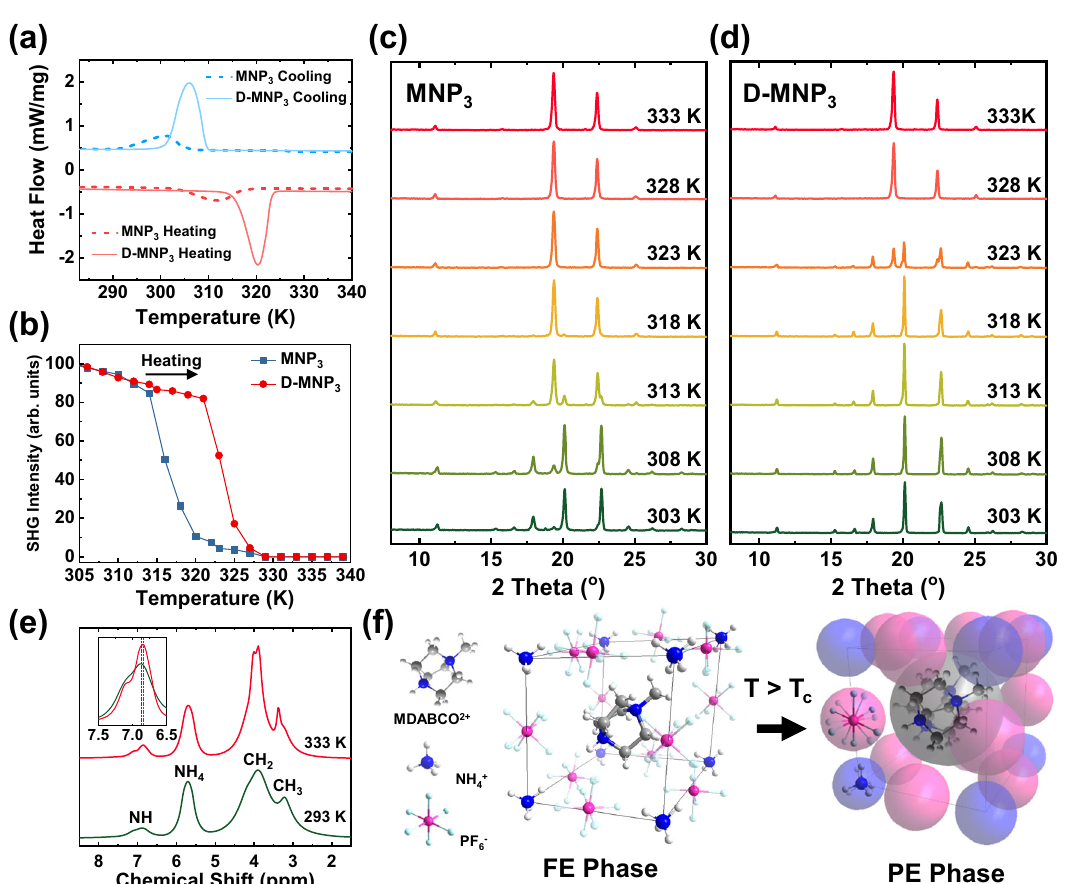
Fig. 3 The ferroelectric-to-paraelectric transition of MNP 3 and D-MNP 3 crystal. a DSC and b temperature-dependent SHG intensity change of MNP 3 and D-MNP 3 revealing phase transition from ferroelectric (FE) phase to paraelectric (PE) phase, and that D-MNP 3 has a higher T c than MNP 3 . Temperature- dependent PXRD result of MNP 3 ( c ) and D-MNP 3 ( d ). e Solid-state 1 H NMR spectrum of MNP 3 at 293 K (FE phase) and 333 K (PE phase). Inset shows peak shift (6.88 – 6.84) of N – H in MDABCO indicating shrinkage of N – H bond. f Schematic illustration of MNP 3 structure in ferroelectric (FE) phase and paraelectric (PE) phase. In the PE phase, molecules rotate